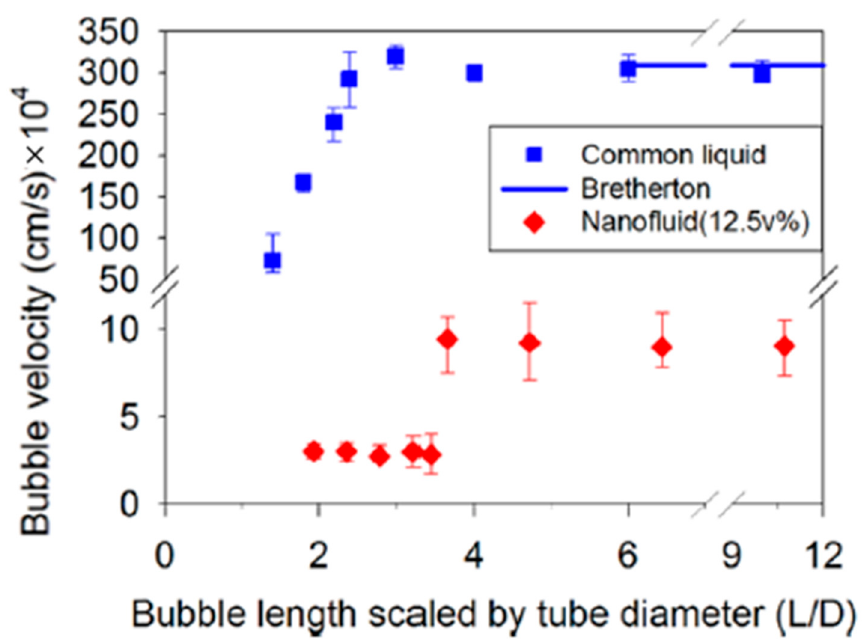
Figure 5. Bubble velocity as a function of the bubble length scaled by the tube diameter (L/D) in a silica nanofluid and a common liquid. The classical Bretherton prediction of the bubble rising velocity for a common liquid is shown as a solid blue line. Reprinted with permission from [34]. Copyright 2017 American Chemical Society